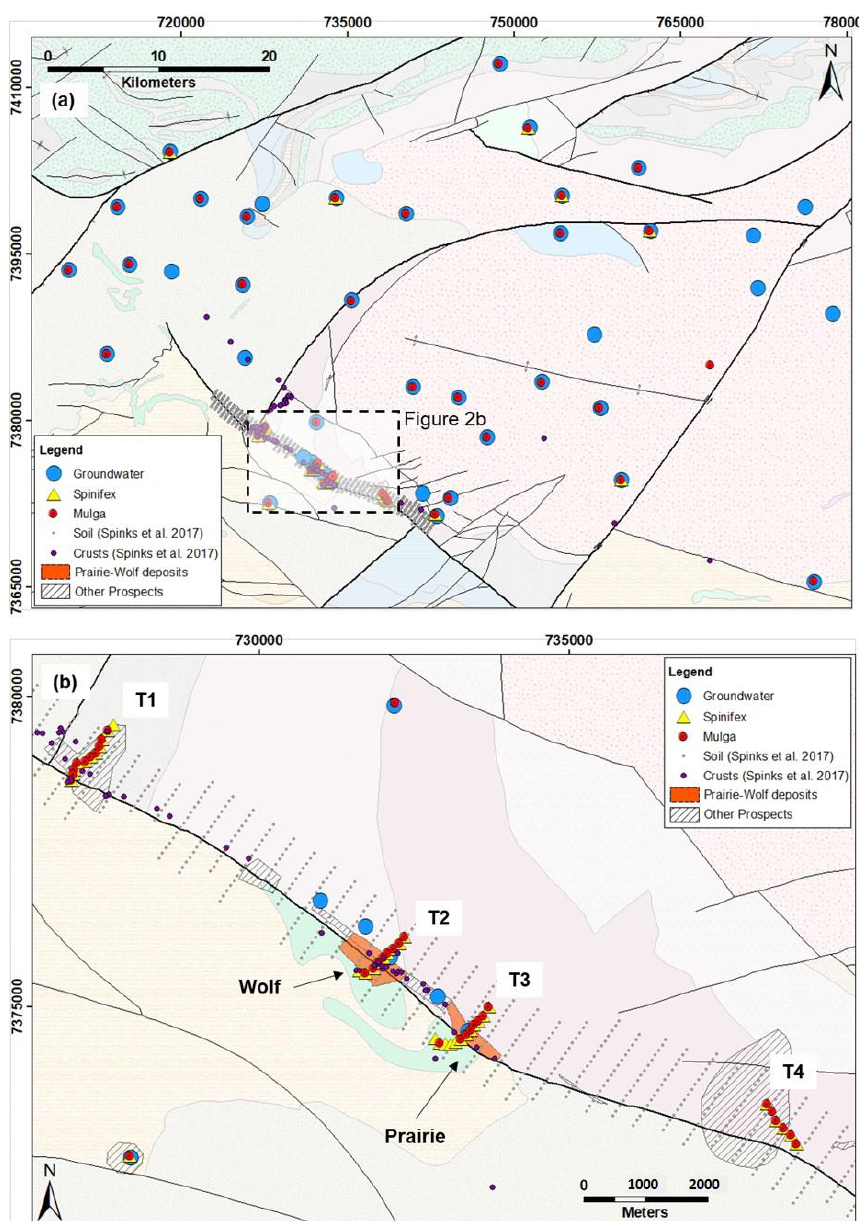
Figure 2. Sample locations ( a ) over the region and ( b ) over the Prairie Wolf deposits and associated prospects. T1 to T4 indicate sampling transects of mulga and spinifex plants. Please refer to the Supplementary Data for a lithological legend.